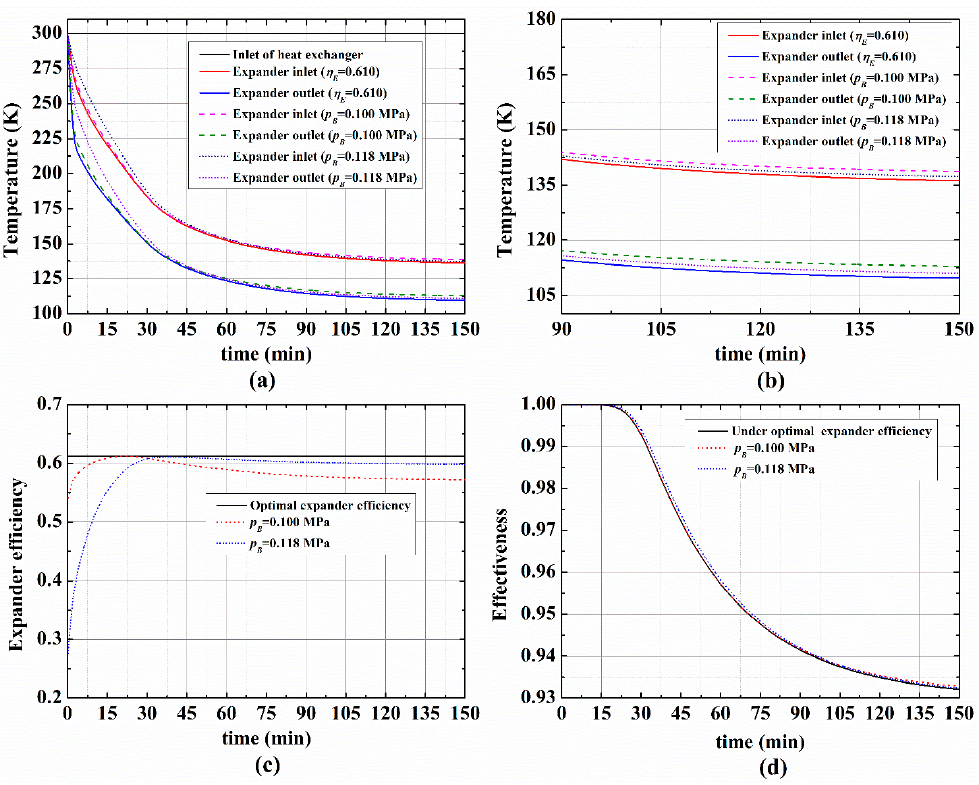
Figure 6. Comparisons between different conditions: ( a ) Cooling characteristics; ( b ) cooling characteristics in the later period; ( c ) variation of expander efficiency; ( d ) variation of heat exchanger effectiveness.